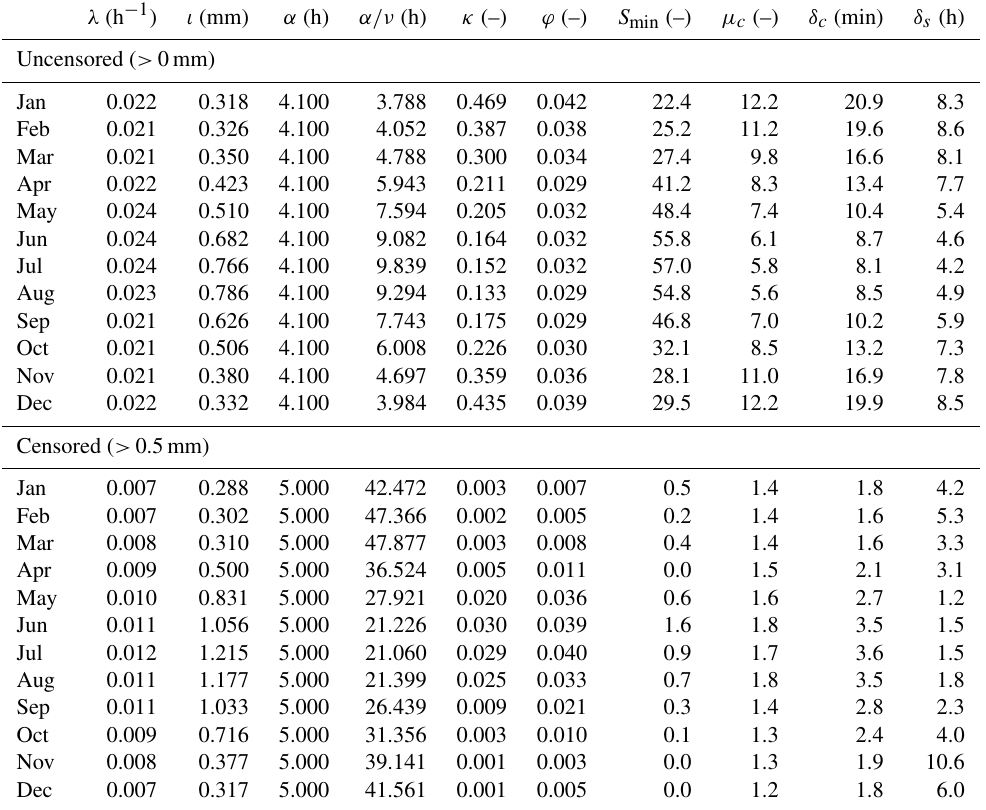
Table B1. BL1M model parameters for the Bochum 5min